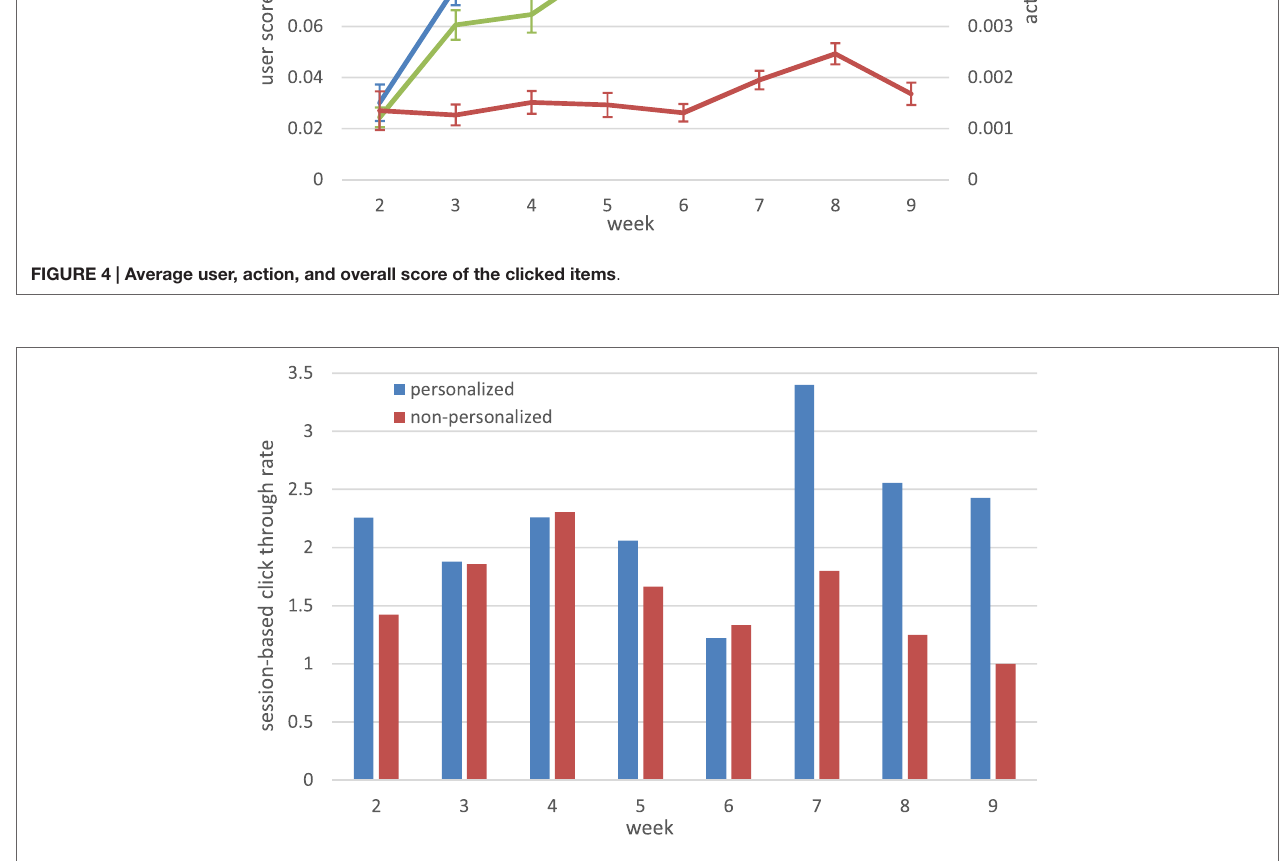
FigUre 5 | session-based click-through rate